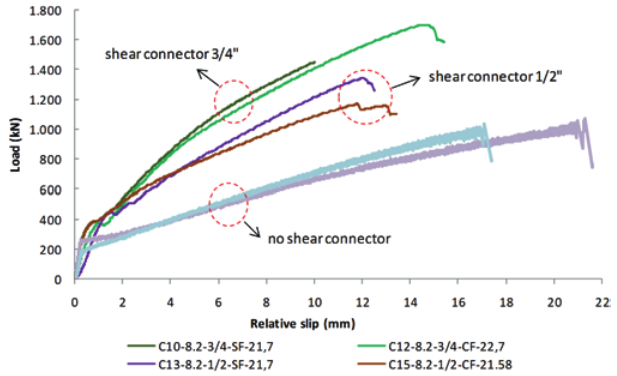
Figure 20 Comparison between the curves load versus displacement relative to the tube 219x15,1 of series A and